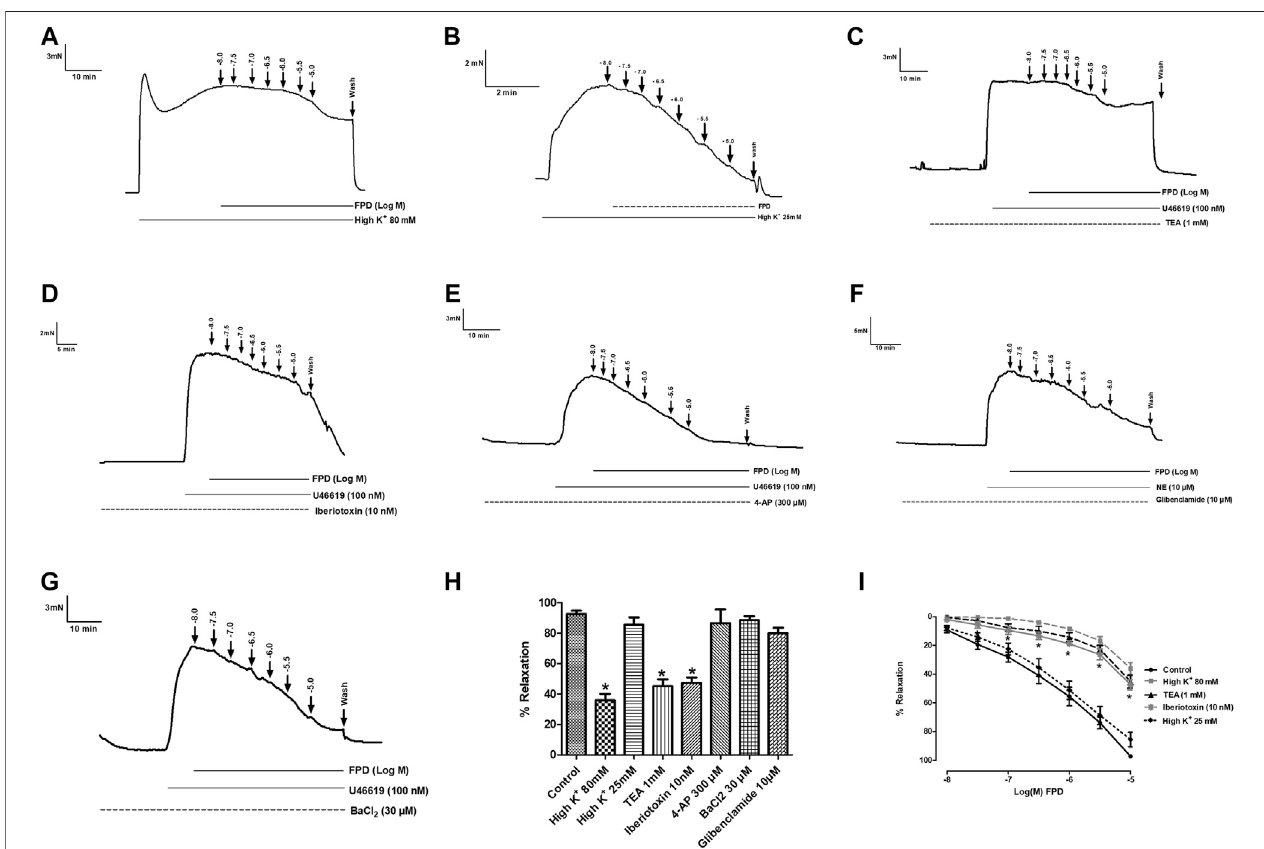
FIGURE4| TracesshowingFPD-inducedconcentrationdependentrelaxationinratsuperiormesentericarterialringspre-constrictedwith80 mMofhighK + MKHS (A) and 25 mMofhigh K + MKHS (B) .TracesshowingFPD-inducedconcentrationdependentrelaxation inarterialrings pre-incubatedwithpotassiumchannel blockers; tetraethylammonium (TEA, 1 mM), iberiotoxin (10 nM), 4-aminopyridine (4-AP, 300 µM), glibenclamide (10 µM), and barium chloride (BaCl 2 , 30 µM) for 20 min and pre- constricted with U46619 (100 nM)/NE (10 µM) (C – G) . Relaxation is expressed as the mean ± S.E.M. ( n (cid:2) 6; * p < 0.05 compared to control and 25 mM of high K + MKHS) percentage reversal of contraction (H) . (I) shows the sigmoidal concentration response curve obtained in (A − D)